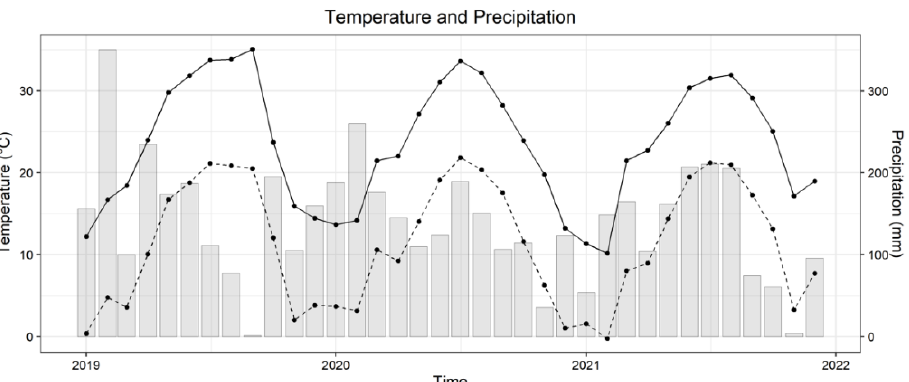
Figure 1. Monthly temperature and precipitation from January 2019 to December 2021. The solid line is the average daily maximum temperature of the month; the dashed line is the average daily minimum temperature; grey bars are monthly precipitation (Data source: Mississippi State University Extension, Delta Agricultural Weather Center).